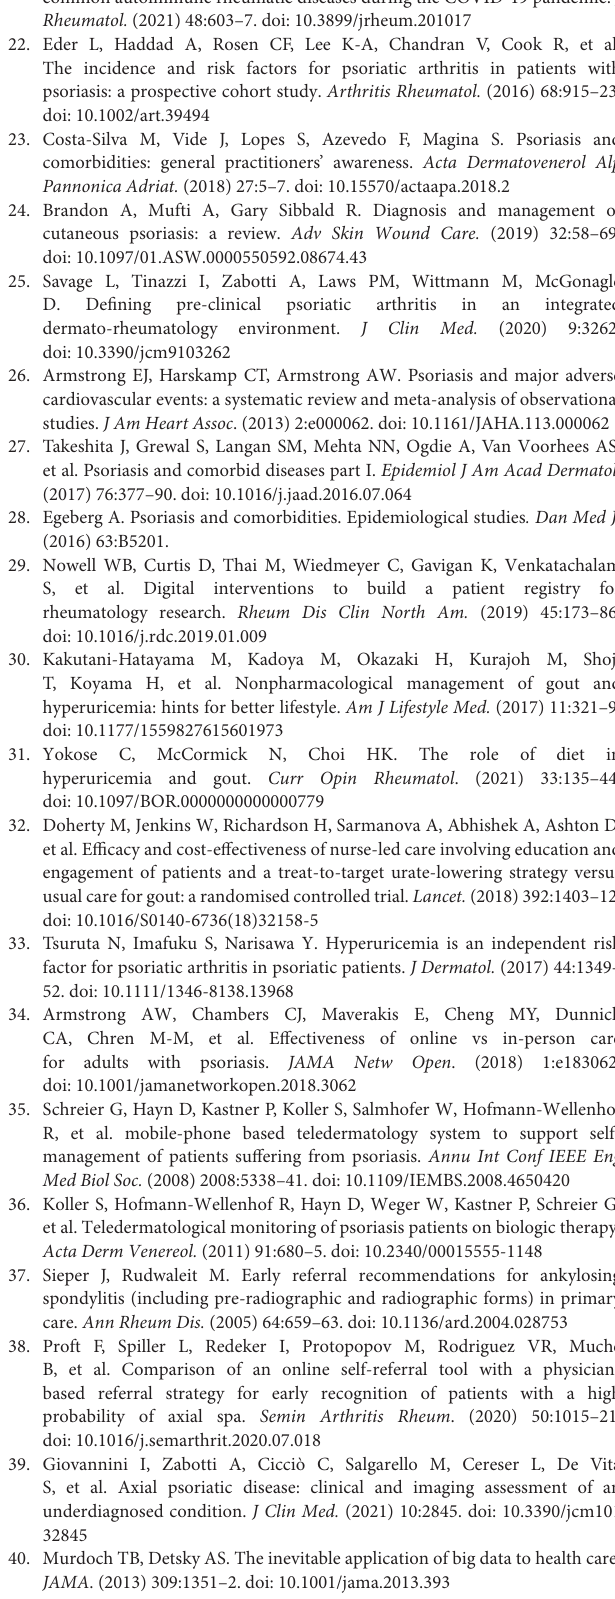
based referral strategy for early recognition of patients with a high probability of axial spa. Semin Arthritis Rheum . (2020)